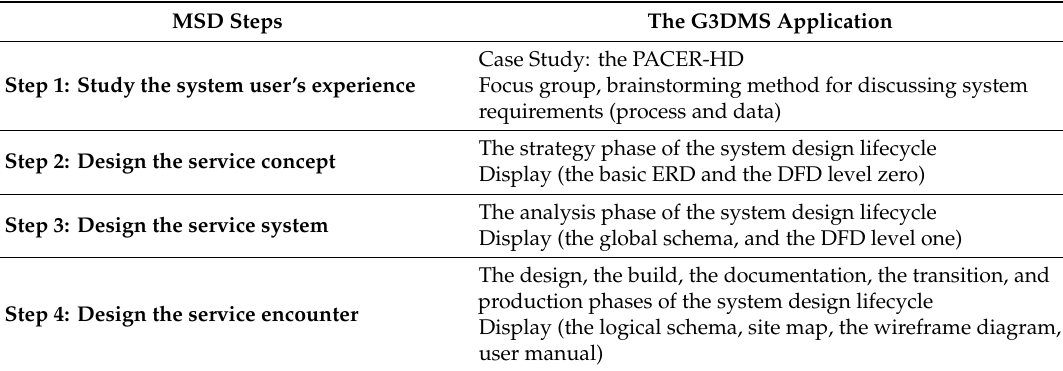
Table 4. The multilevel service design approach for the development of the G3DMS.